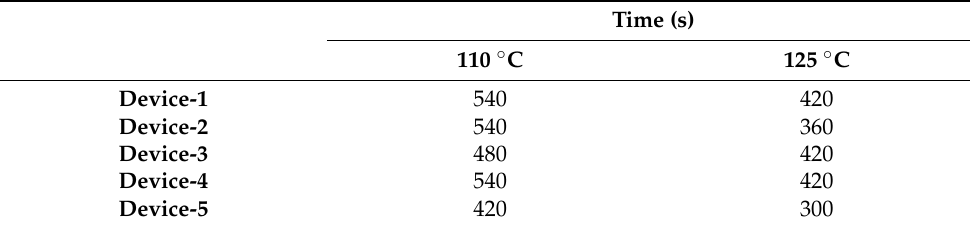
Table 3. Time required for the fabrication of µ PADs with the same shapes at the top and at the bottom sides of the paper substrate at two temperatures, n = 3; error: ± 5 s.